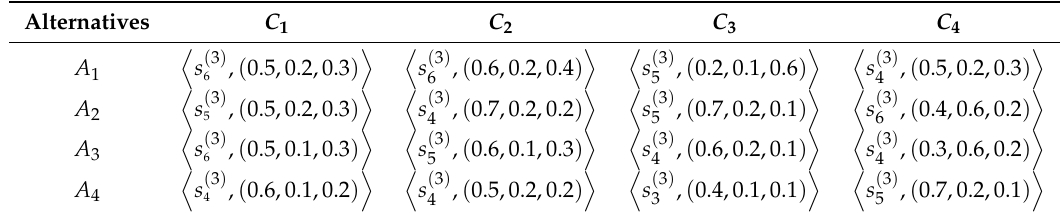
Table 6. Standardized SVNL decision matrix R 3 .